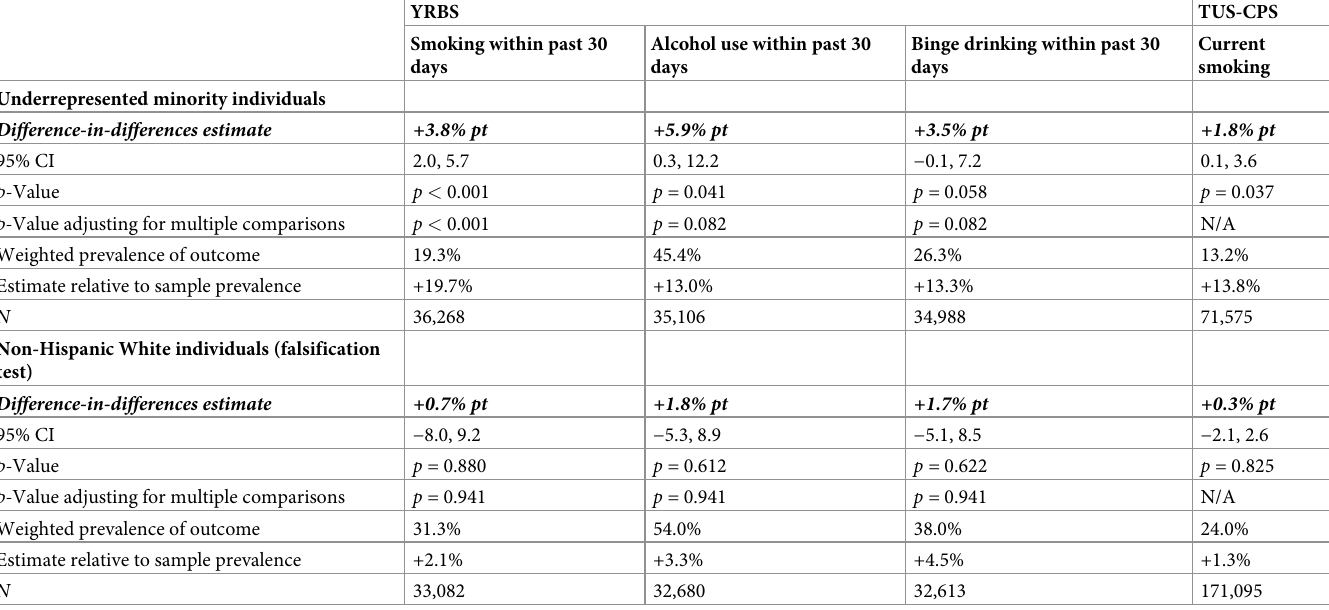
Table 2. Difference-in-differences estimates for underrepresented minority and non-Hispanic White respondents. YRBS TUS-CPS Smoking within past 30 Alcohol use within past 30 days